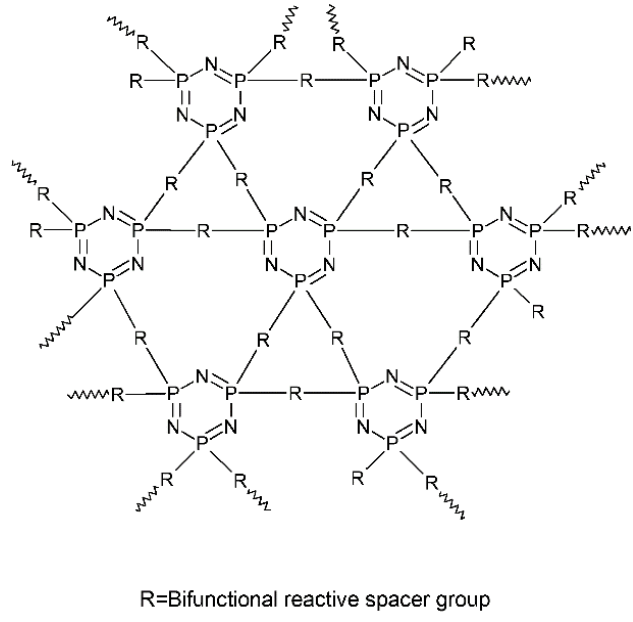
Figure 3. Schematization of a cyclomatrix polyphosphazene.